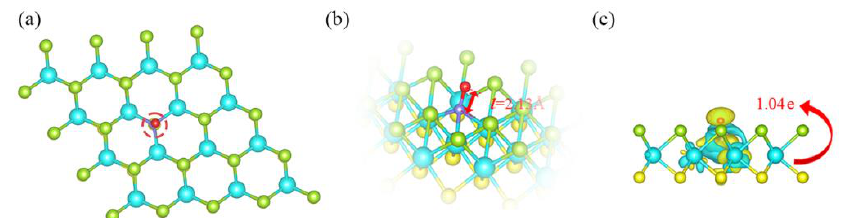
Figure 5. ( a ) Top, ( b ) side, and ( c ) CDD images of the optimal structures for the adsorption system under the defective WSSe case. The l in red stands for N-O bond length. Charge accumulation (depletion) is indicated by areas that are yellow (cyan). The value of the isosurface is 0.002 e Å − 3 . The red number in CDD image indicates how much charge transferred from the substrate to the molecule.